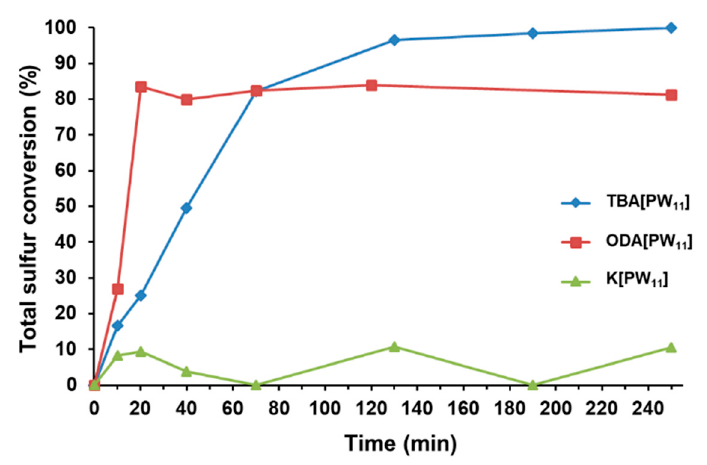
Figure 1. Kinetic profiles for the desulfurization of a model diesel under the solvent-free system, catalyzed by TBA[PW 11 ], ODA[PW 11 ] or K[PW 11 ], using H 2 O 2 as oxidant (H 2 O 2 /S = 3) at 70 °C.